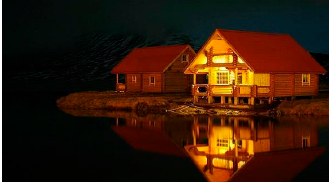
Figure 15. Original image.